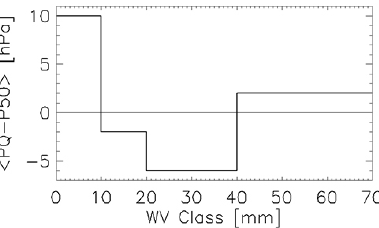
Fig. 6. ( P 50 − P Q ) quantity versus water vapour, averaged over the four W